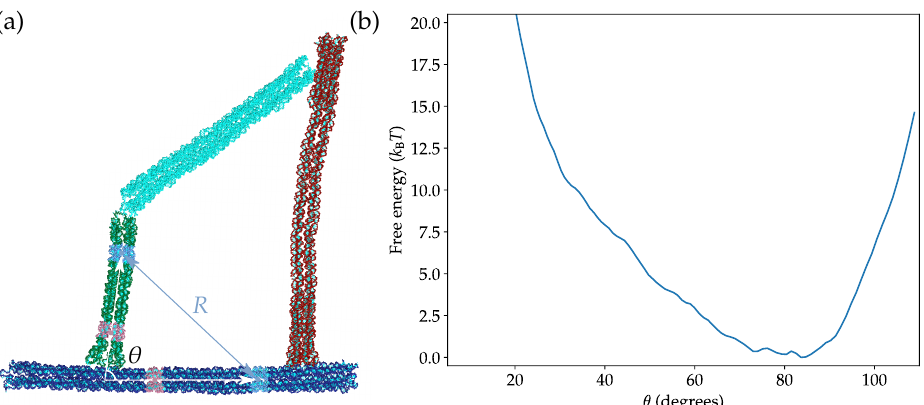
Figure 2. ( a ) A configuration of the origami illustrating the definition of the order parameter R as the distance between the centres of mass of the two groups of nucleotides coloured in light blue. The value of θ was tracked in the simulations, and is defined as the angle between the two vectors coloured in white. The vectors pass through the centres of mass of the two groups of nucleotides coloured in light red and light blue in the crank block and the frame block, respectively. ( b ) The free-energy landscape of the origami as a function of θ at T = 300